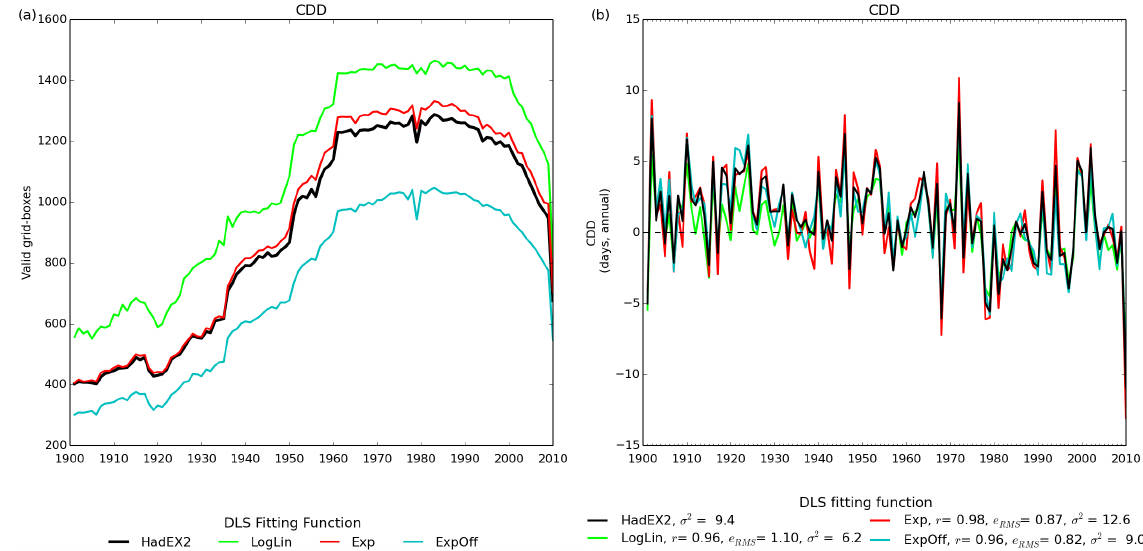
Figure 12. (a) The number of non-missing grid boxes and (b) the time series for global average CDD for the different DLS calculation